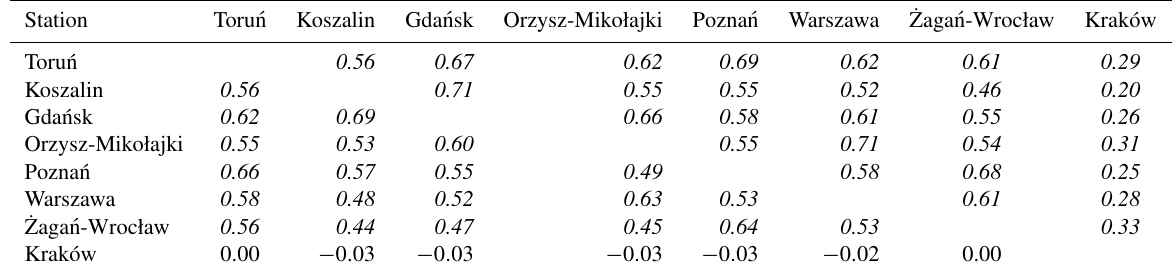
Table 7. Correlation coefficients between monthly totals of atmospheric precipitation (upper part of table) and SPI1 (lower part of table) in the area of Poland calculated based on data from the period 1901–2000.